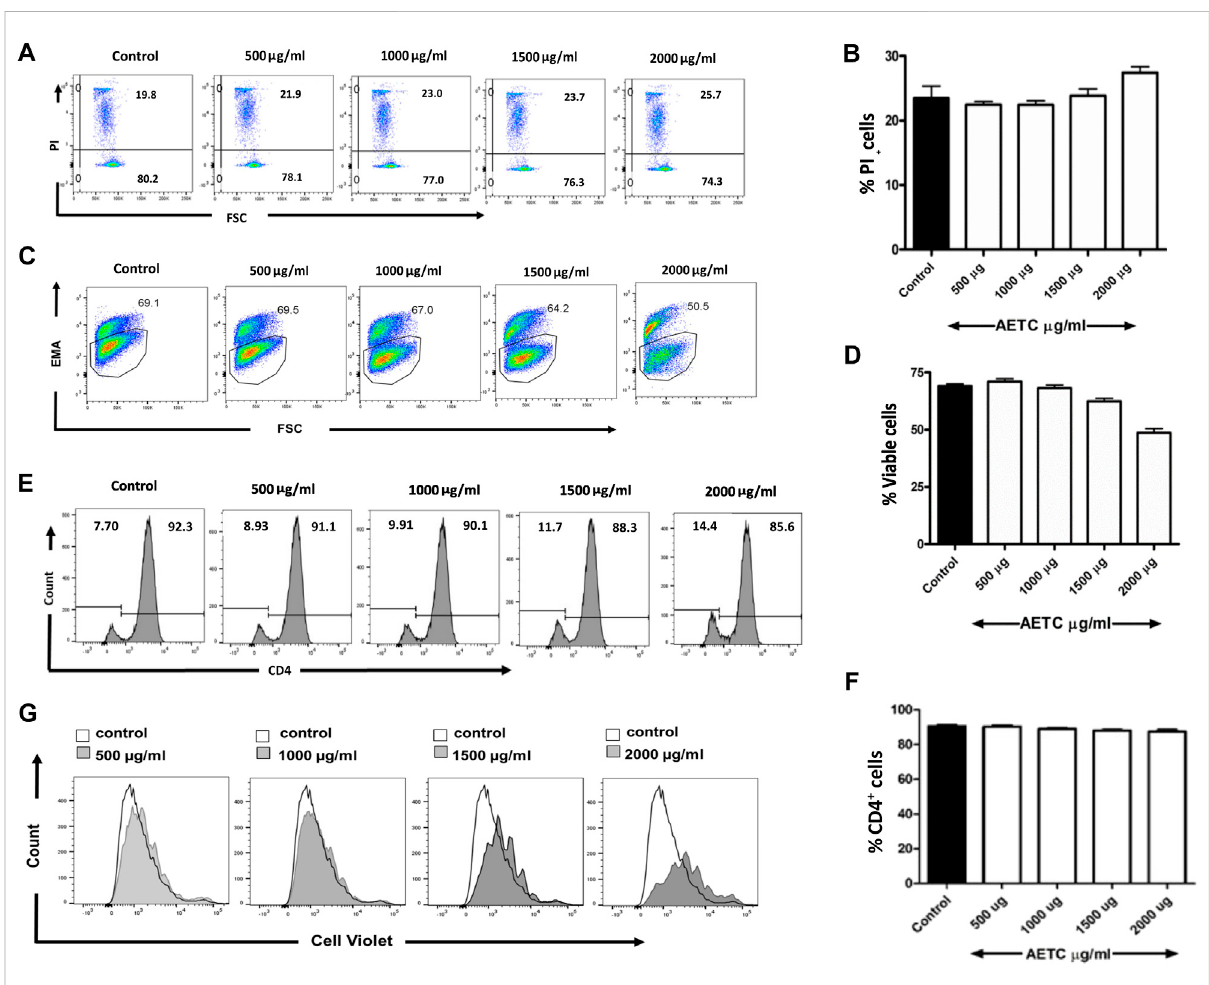
FIGURE 1 T. cordifolia aqueous extract does not exhibit cytotoxicity in primary CD4 + T cells. Naive T cells were isolated from C57BL/6 mice, stimulated with anti-CD3 andanti-CD28 mAb,and cultured in thepresence ofAETC(500 – 2000 µg/ml) orvehiclecontrolfor 24 and96 h.Representative fl ow cytometry showing the percentage of (A) PI positive cells following the culture of naive T cells for 24 h and (C) EMA positive cells for 96 h in the presenceofAETC(500 – 2000 µg/ml)orvehiclecontrol.Bargraphsrepresentthequanti fi cationof fl owcytometrydatafor (B) 24 hand (D) 96 h of AETC treatment or vehicle control. (E) Histogram and (F) bar diagram representing cell surface expression of CD4 molecule on naive T cells, stimulated with anti-CD3 and anti-CD28 mAb and cultured in the presence of AETC (500 – 2000 µg/ml) or vehicle control for 96 h (G) The proliferation of AETC (500 – 2000 µg/ml) or vehicle control as assessed by the cell proliferation dye CellTrace violet. Cells were stained for CD4 and gated on live CD4 + T cells. Results are representative of three independent experiments. Error bars represent the mean ± SEM of triplicates. * p <